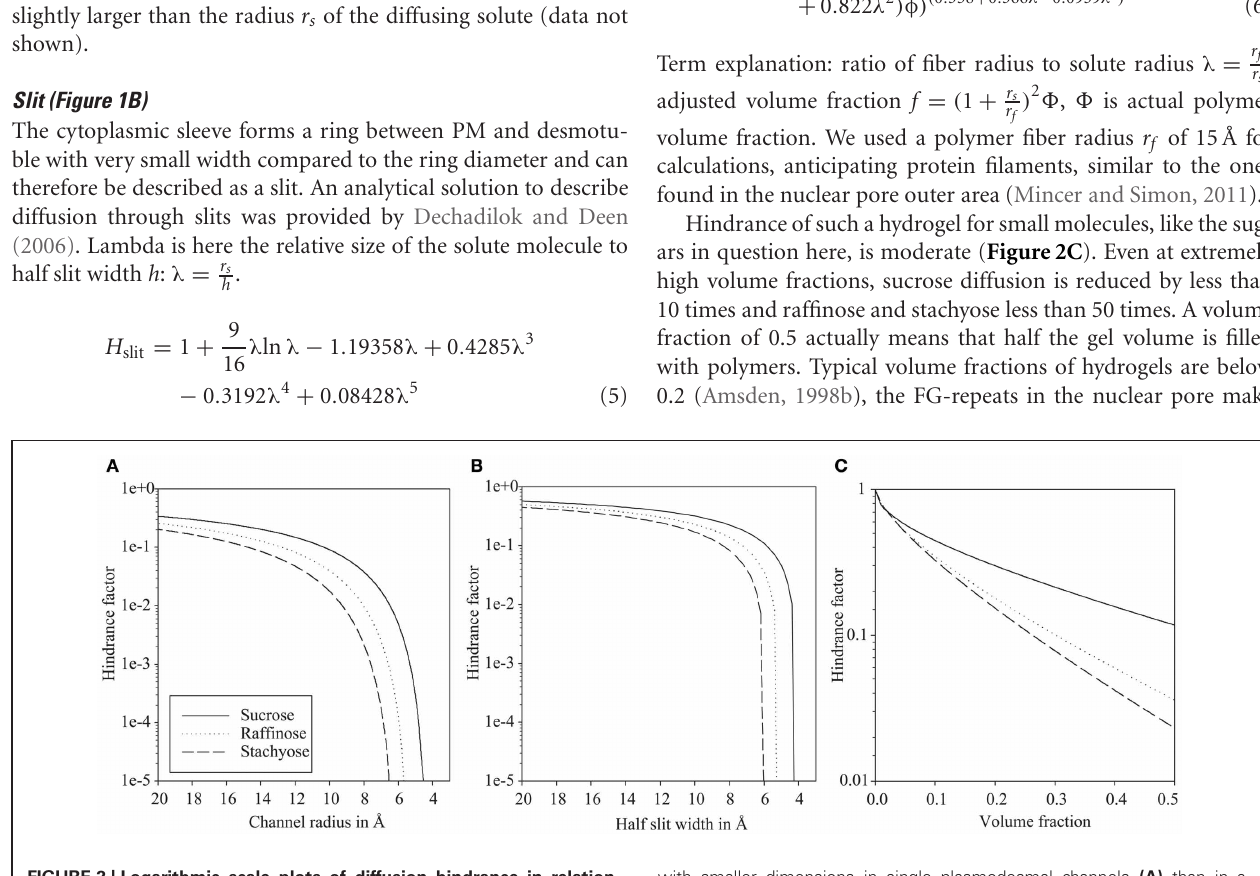
FIGURE 2 | Logarithmic scale plots of diffusion hindrance in relation to hypothetical plasmodesmata substructure configurations. Hindrance factor for sucrose, raffinose, and stachyose increases faster